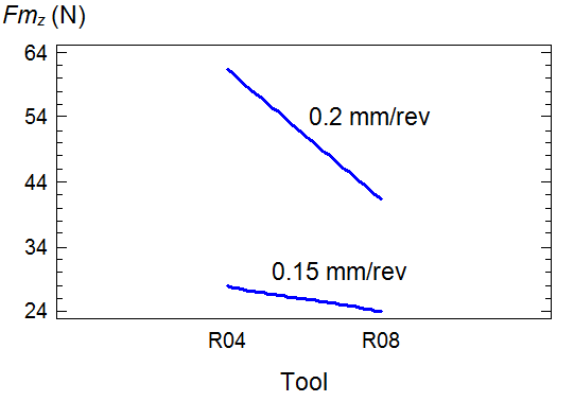
: tool and feed rate. z